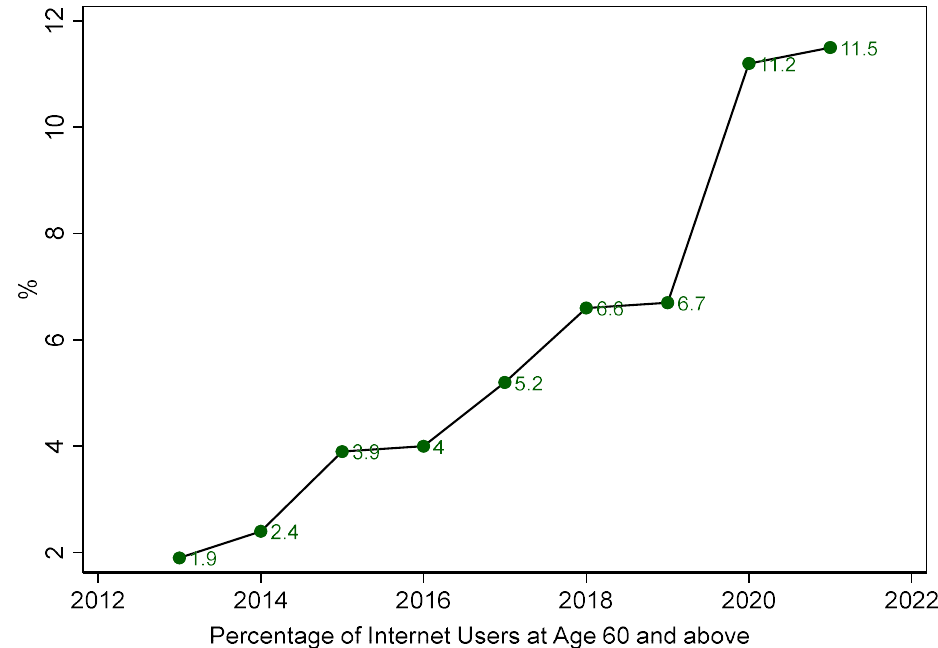
Figure A1. The increasing trend of internet users age 60 and above in China. Source: China Internet Network Information Center (CINIC).